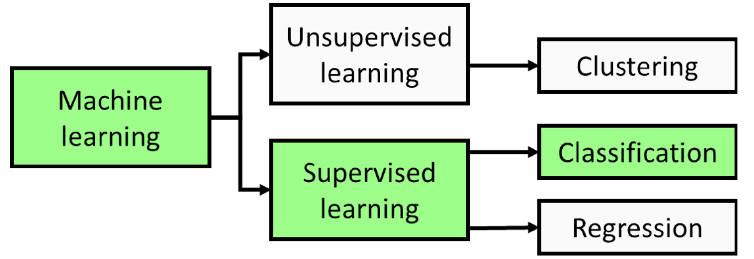
Figure 6. Main types of machine learning.